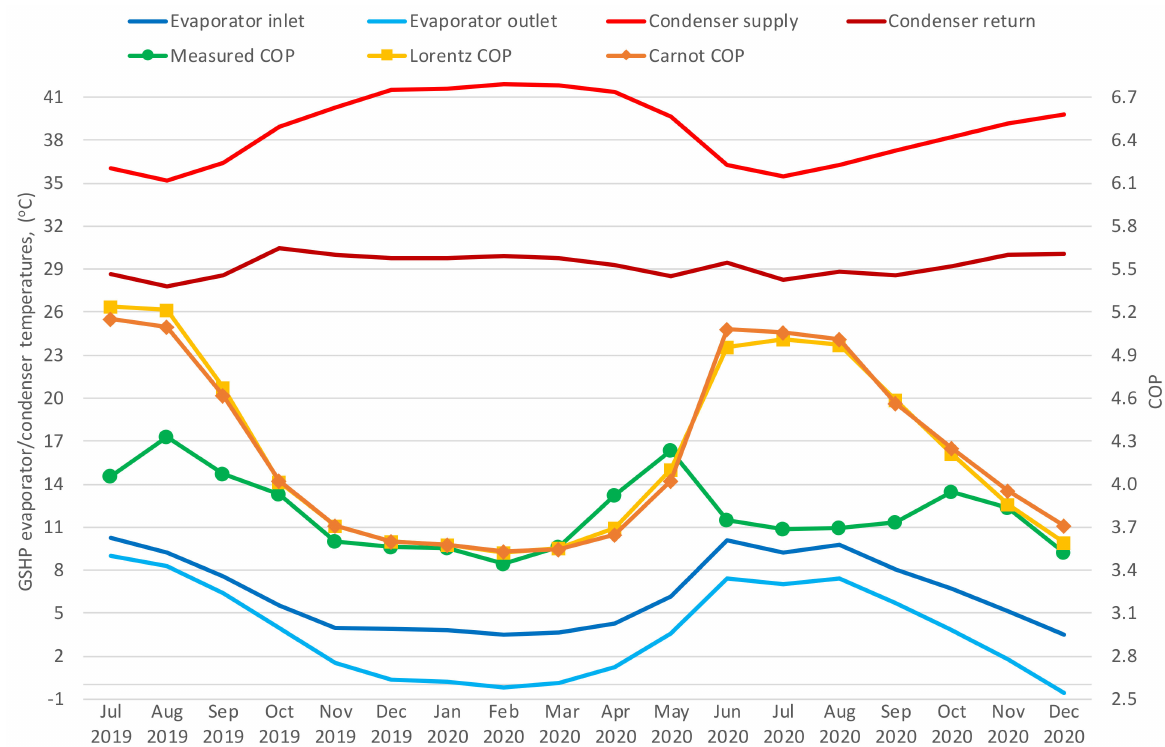
Figure 13. GSHP evaporator/condenser fluid temperatures and